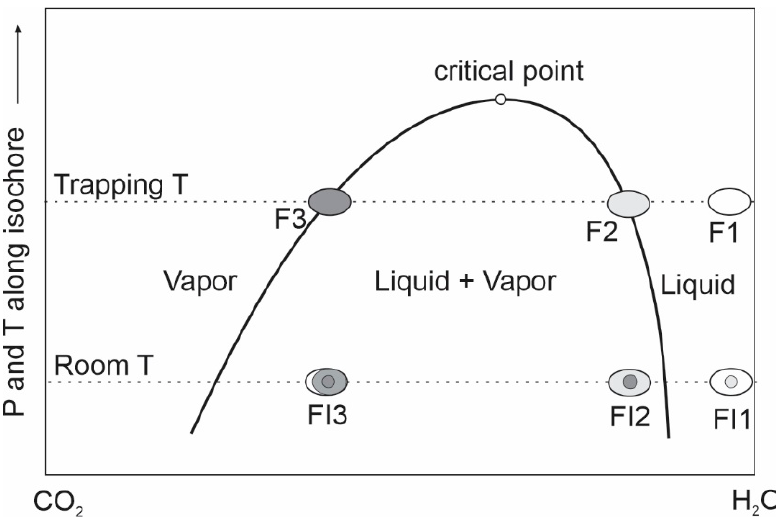
Figure 4. A schematic phase diagram for the H 2 O–CO 2 system (modified from [38]) illustrating that a maximum of two fluid phases can coexist at the trapping condition, representing the liquid (F2) and vapor (F3) phases that confine the liquid + vapor immiscibility field. An additional liquid phase (F1) cannot coexist with F2 because they are in the one-phase (liquid) field.